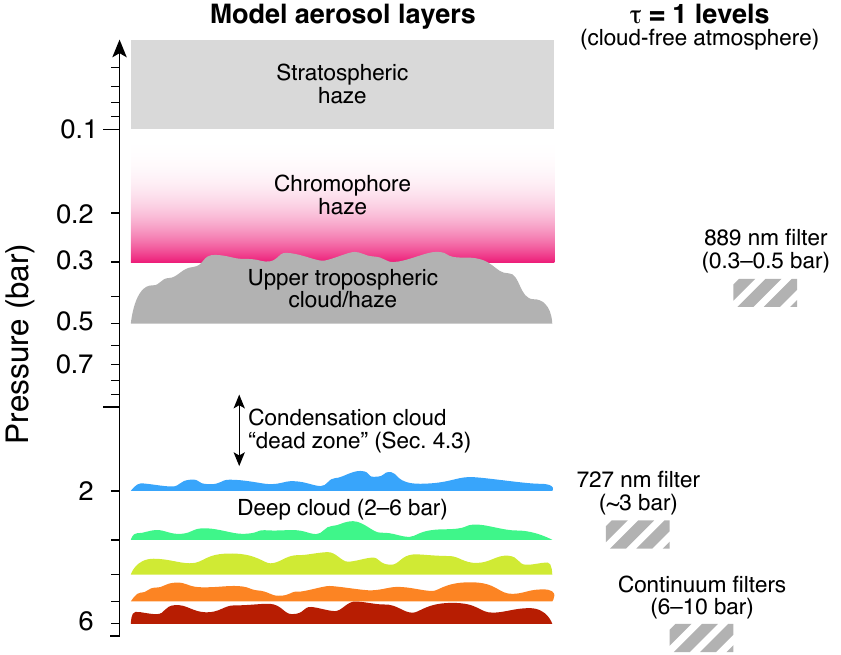
Figure 9. Our aerosol framework includes deep (2–6 bar) clouds, in addition to upper clouds and hazes (see also Table 2). The framework is similar to the cloud structure of West et al. [1,66], but agnostic as to the composition of the deep clouds. The combination of a blue-absorbing chromophore haze and a higher-opacity, conservatively-scattering cloud/haze layer beneath it follows the “crème- brûlée” framework used in several recent works [65,84–86]. Levels where clear gas opacity reaches unit optical depth for two-way scattering of sunlight back to the observer are shown as hatched boxes for continuum and methane-band filters, with levels from Figure 3 of Fry and Sromovsky [65] and Figure 2 of Banfield et al.